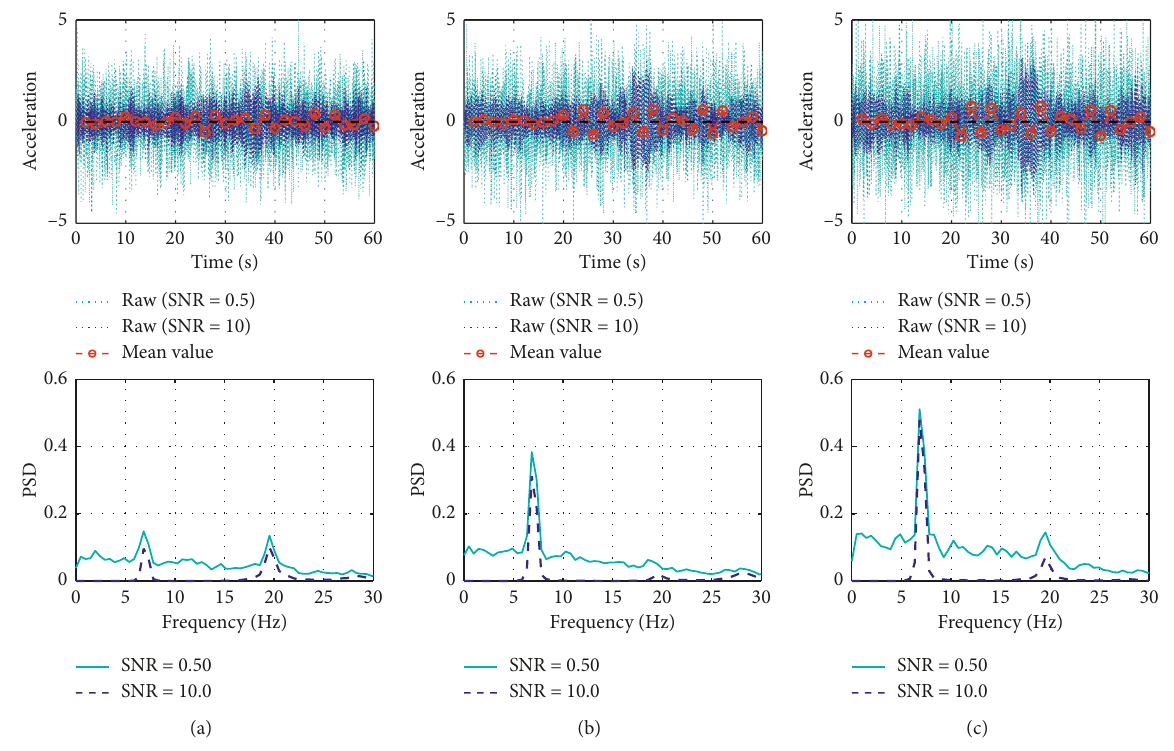
Figure 3: Example of the time-domain responses and corresponding